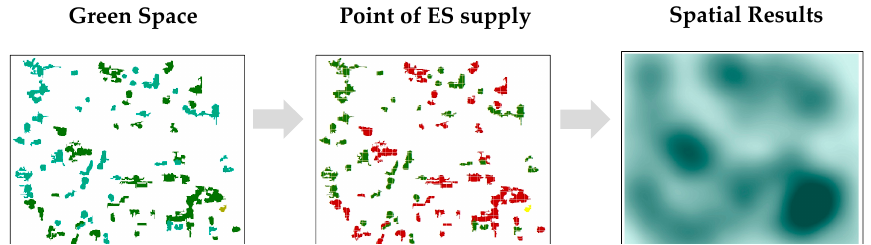
Figure 5. Grid spatialization method of ecosystem service (ES) supply.